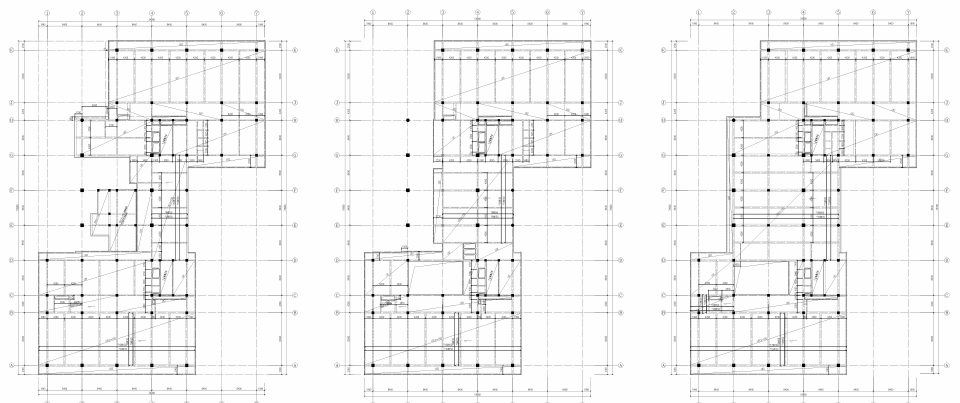
Figure 5. Structural plan layout of reference building.